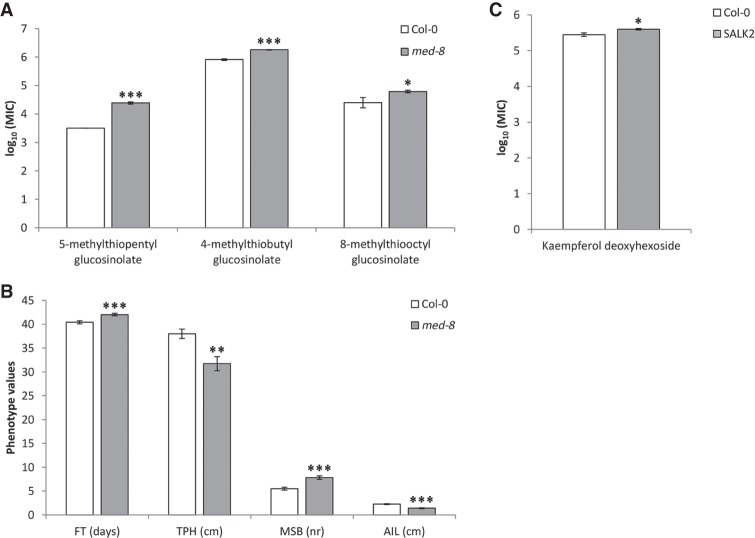
Metabolic and morphological trait analyses in mutants and wild type. (A) Metabolic values for three different glucosinolates (4-methylthiobutyl glucosinolate, 5-methylthiopentyl glucosinolate, and 8-methylthiooctyl glucosinolate) in Col-0 wild type and the med-8 mutant. (B) Phenotypic trait values for flowering time (FT), total plant height (TPH), main stem branching (MSB), and average internode length (AIL) in col-0 wild type and the med-8 mutant. (C) Metabolic values for kaempferol deoxyhexoside in Col-0 wild type and the AT3G24360 knock-out mutant (designated SALK2 here; see Supplemental Material for details). (*) P < 0.05, (**) P < 0.01, (***) P < 0.001.